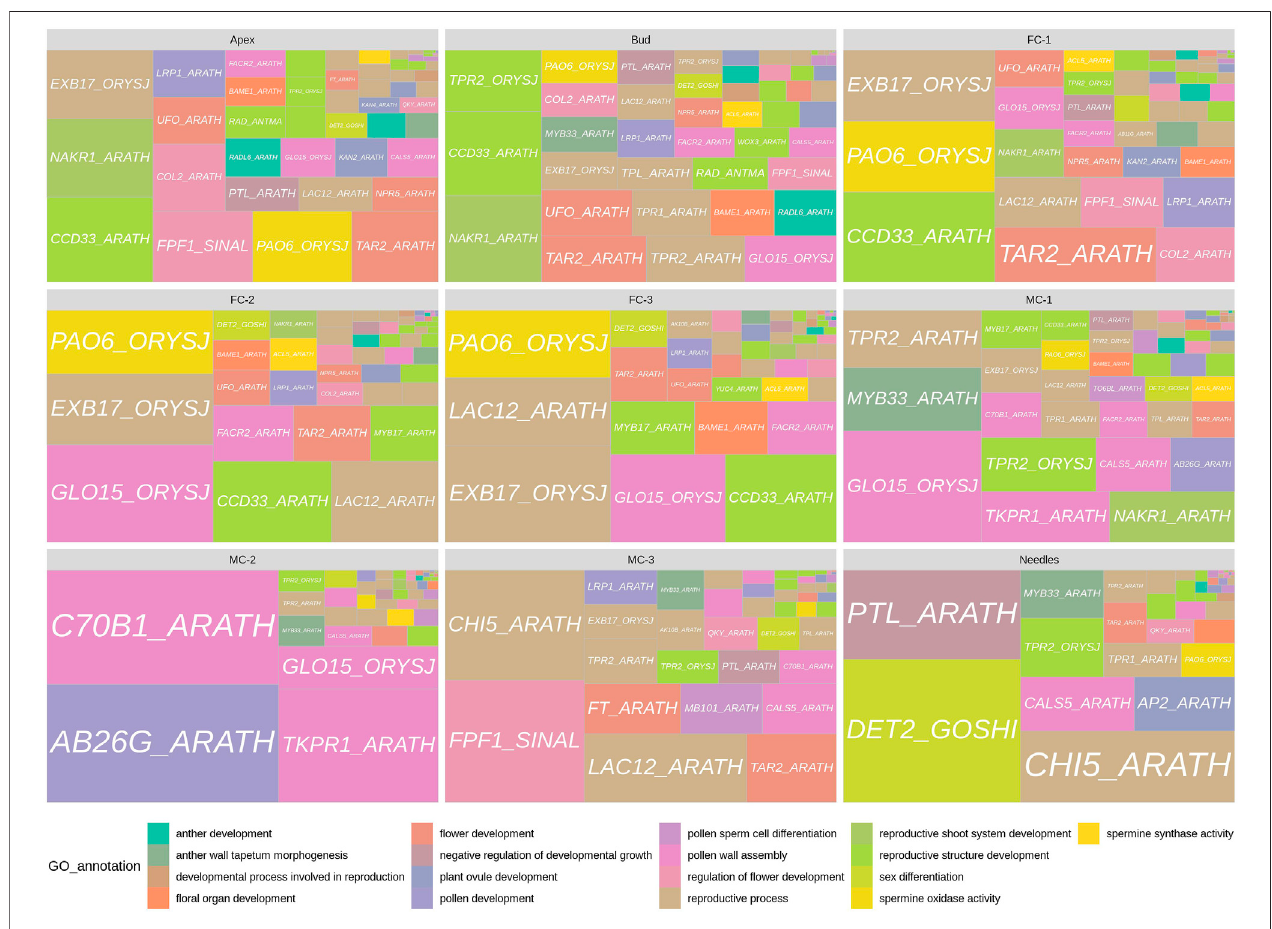
FIGURE5 | Panel of geneswith fl oralrelatedGO terms for each tissue.Gene labels are derived from PFAM transcriptsannotation. GO annotations related toeach genelabelarerepresentedbycolors.Thesquaresaredifferentiallyexpressedtranscriptsannotatedastherepresentedgenelabelandthesizeofthesquaresareequalto the sum of each transcript normalized counts over all replicates for the given